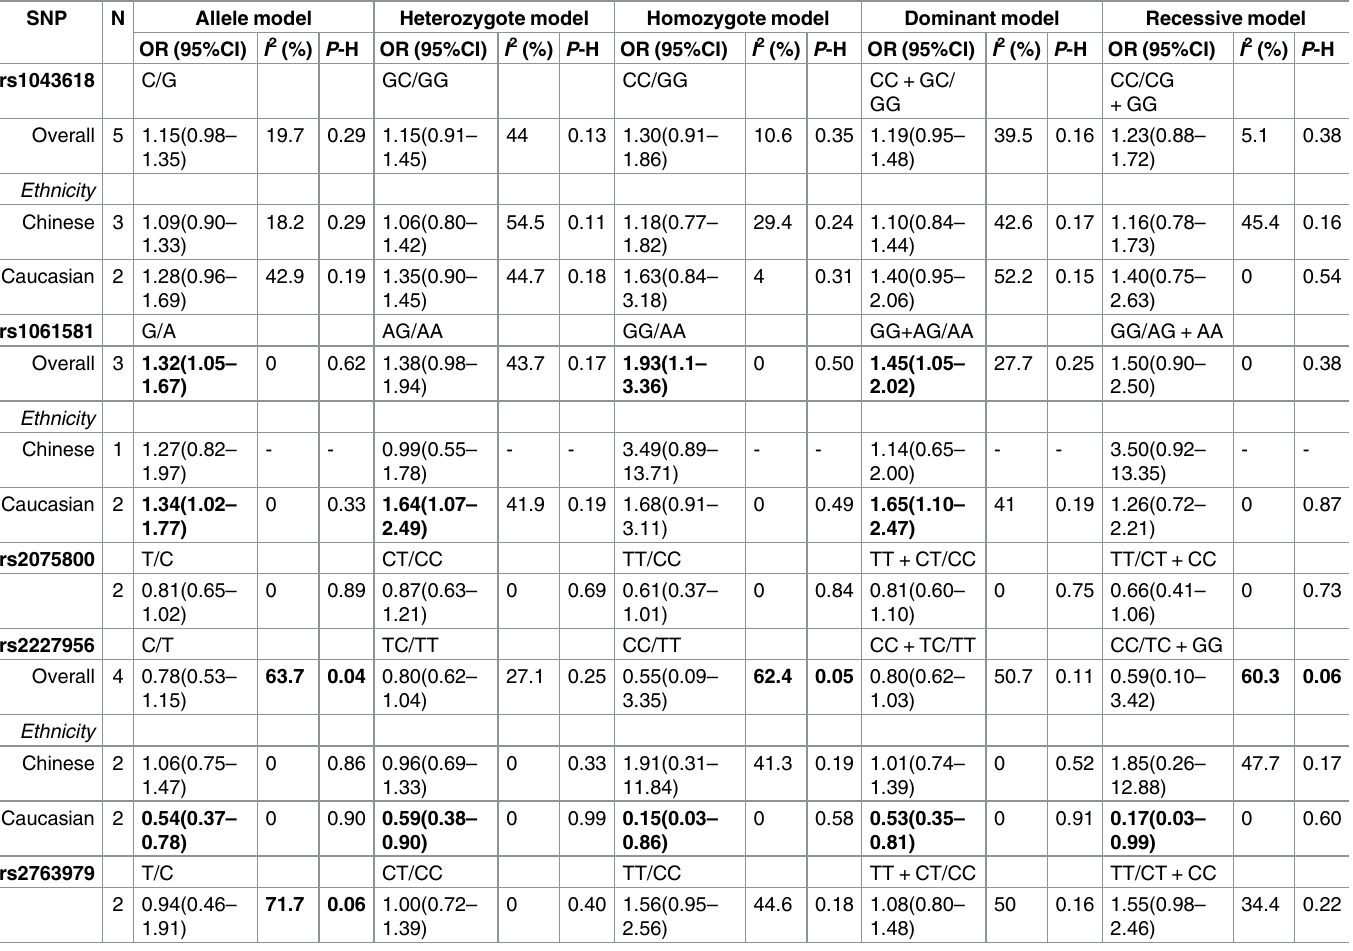
Table 2. Summaryof pooled ORs in the